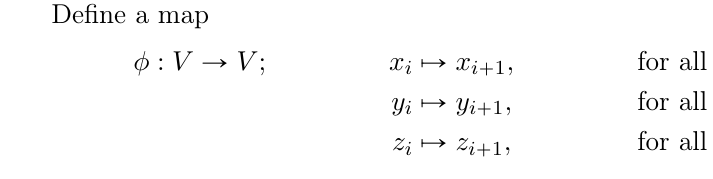
Figure 2. Let ∆ be the subgraph induced by W “ V ´ t y as shown in Figure 3. Note that Γ and ∆ are trees and in particular